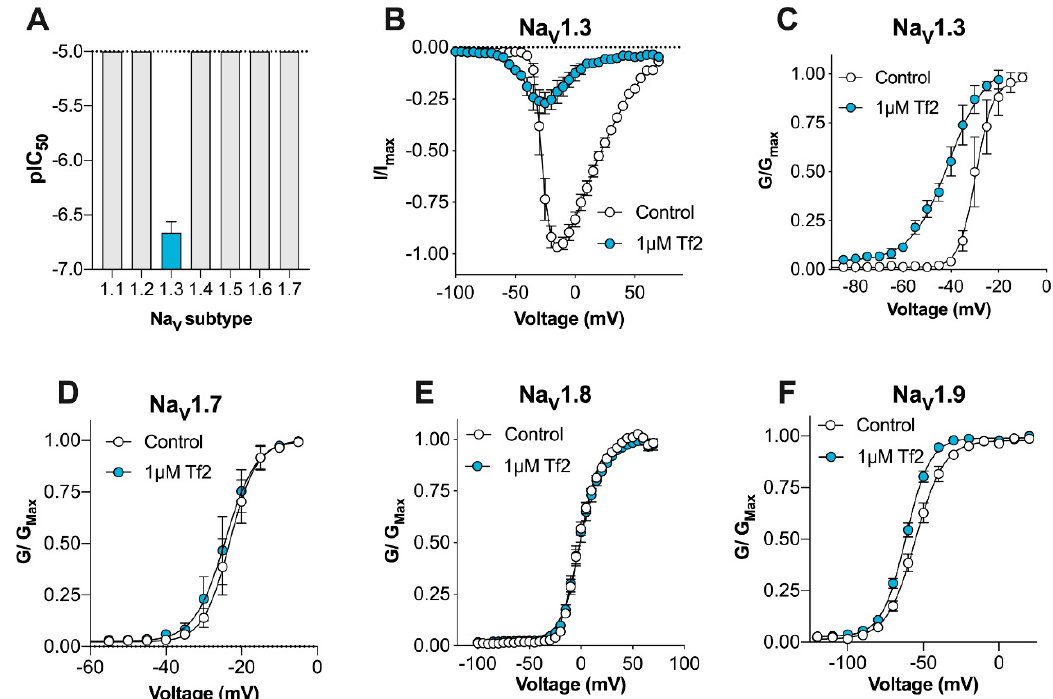
Figure 1. Synthetic Tf2 shifts the voltage dependence of activation at hNa V 1.3 and hNa V 1.9_C4. ( A ) Synthetic Tf2 retains selectivity for hNa V 1.3, with no effect on hNa V 1.1, hNa V 1.2, or hNa V 1.4–1.7 up to 10 µ M in the FLIPR Tetra membrane potential assay ( n = 4–6 wells) ( B ) hNa V 1.3 current–voltage relationshipbefore(whitecircles)andaftertheadditionof1 µ MTf2(bluecircles). Tf2causesearlychannel opening and an overall decrease in the peak current ( n = 5 cells). ( C ) hNa V 1.3 conductance–voltage relationship before (white circles) and after the addition of 1 µ M Tf2 (blue circles). Tf2 causes a significant ( ∆ − 11.3 mV) hyperpolarizing shift in the voltage dependence of activation and increases the slope factor ( n = 4 cells). ( D ) hNa V 1.7 conductance–voltage relationship before (white circles) and after the addition of 1 µ M Tf2 (blue circles) ( n = 4 cells). ( E ) hNa V 1.8 conductance–voltage relationship before (white circles) and after addition of 1 µ M Tf2 (blue circles) ( n = 12 cells). ( F ) hNav1.9_C4 conductance– voltage relationship incubated with vehicle (0.1% BSA, white circles) or with 1 µ M Tf2 (blue circles). Tf2 causes a significant hyperpolarizing ( ∆ − 6.3 mV) shift in the voltage dependence of activation and decreased the slope factor ( ∆ − 1.3) ( n = 11–14 cells). Data presented as mean ±